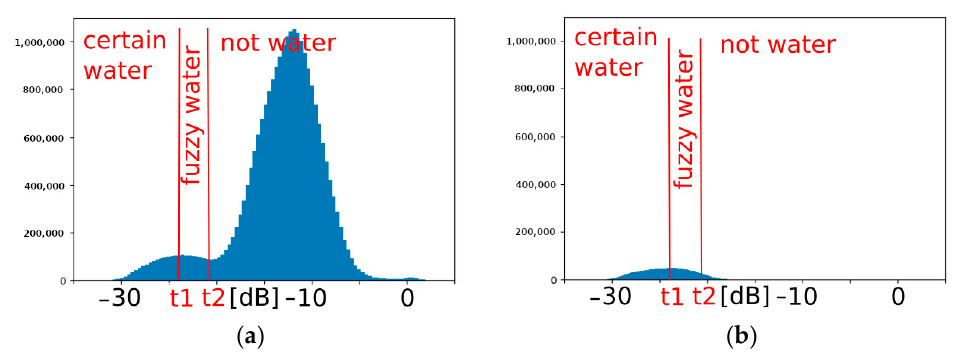
Figure 3. Determination of the water–land threshold based on a bimodal histogram ( a ) and a per- manent water histogram ( b ). permanent water histogram ( b